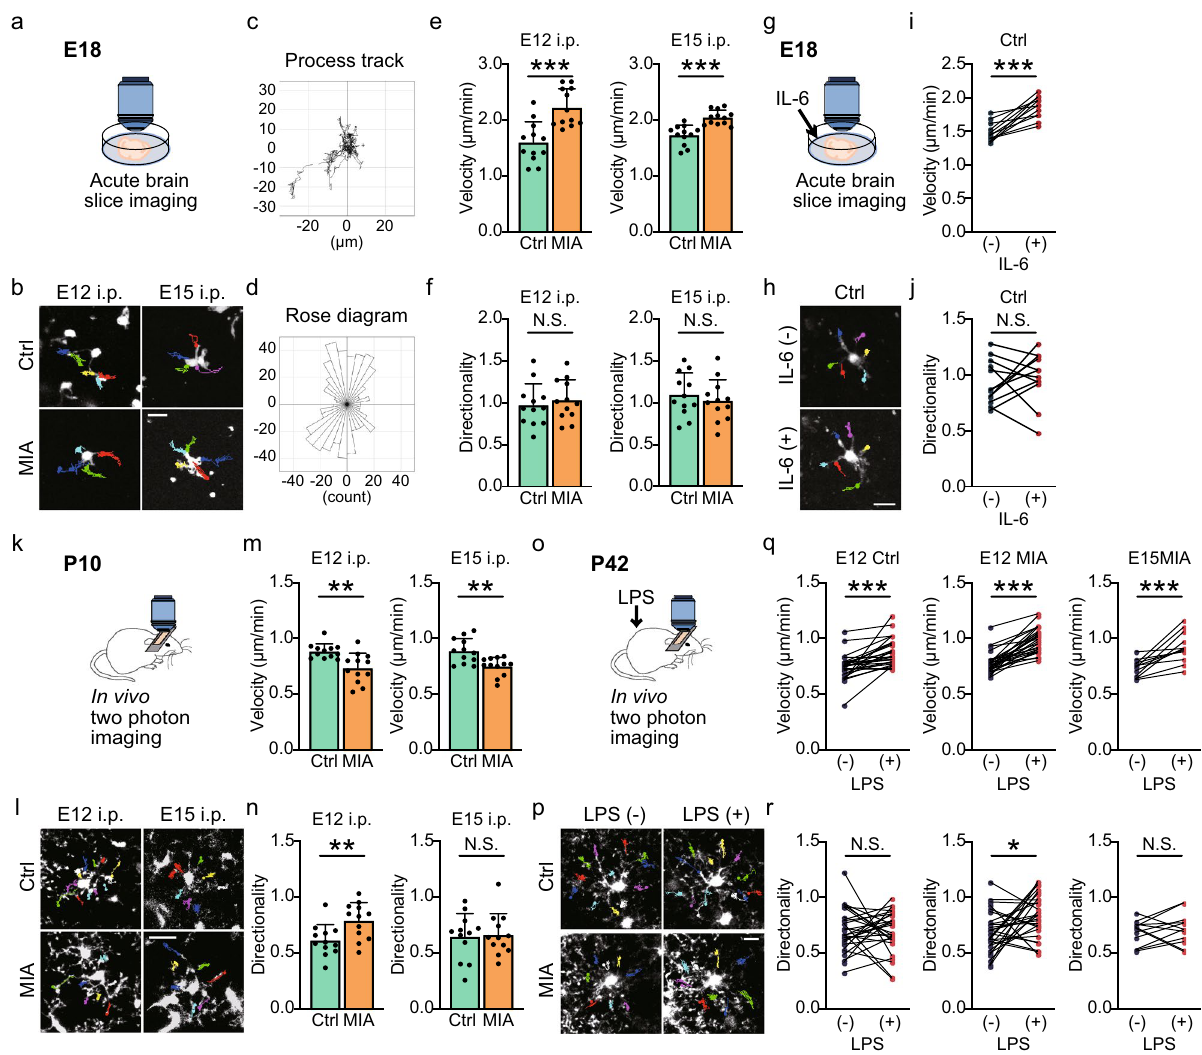
Figure 3. MIA induces sustained changes in patterns of microglial process motility. ( a ) Experimental scheme to illustrate imaging of microglia in the somatosensory cortex in brain slices isolated from E18 offspring of E12 or E15 control (Ctrl; saline -injected) or MIA (Poly(I:C) -injected) mice. ( b ) Representative trajectories of E18 microglial processes from prior control or MIA (E12 and E15) mice. ( c ) A typical microglia process track showing the trajectory of each process tip movement relative to its starting point. ( d ) A tip process track was binned into a Rose diagram using the Migration Tool 2.0 (IBID) to give a directionality profile. Each bin represents the number of process tip tracks moving in that direction. To compare the directionality, the coefficient of variation of each bin (every 10 degrees value) was calculated. ( e , f ) Averaged microglial process tip movement velocity ( e ) and directionality ( f ) for microglia in E18 brains isolated from E12 or E15 Ctrl or MIA mice ( n = 12 cells from 4 mice in each group). ( g ) The inflammatory cytokine, IL-6, was directly added to E18 fetal brain slices from control mice. ( h ) Representative trajectories of microglial processes from E18 slices without and with IL-6 added. ( i , j ) Averaged effects of IL-6 on microglial tip process velocity and directionality ( n = 12 cells from 4 mice in each group). Data from each experiment is shown connected by a line to represent values before and after IL6 application. ( k ) Experimental scheme showing in vivo two-photon imaging of cortical microglia in P10 offspring. ( l ) Representative trajectories of the processes of microglia in a P10 offspring from E12 or E15 saline (Ctrl) or Poly(I:C) (MIA) -injected) mice. Each process from single microglia has a distinct color. ( m , n ) Averaged microglial process velocity ( m ) and directionality ( n ) ( n = 12 cells from 4 mice in each group). ( o ) Schema demonstrating in vivo two-photon imaging of microglia in somatosensory cortex of P42 mice before and after LPS injection. ( p ) Representative trajectories of microglial processes in P42 offspring from E12 saline-injected (Ctrl) or Poly(I:C) -injected (MIA) mice before and after systemic injection of LPS. ( q , r ) Grouped effects of LPS on microglial process velocity ( q ) and directionality ( r ) in E12 Ctrl and MIA mice, and E15 MIA mice (E12: n = 28 cells from 8 mice; E15: n = 12 cells from 4 mice). For all column graphs, columns represent mean ± standard deviation, while dots show data from each process. For ( q ) and ( r ), each experimental data point is shown with values before and after LPS connected by lines. * P < 0.05, ** P < 0.01, *** P < 0.001 and N.S.: not significant, unpaired or paired t